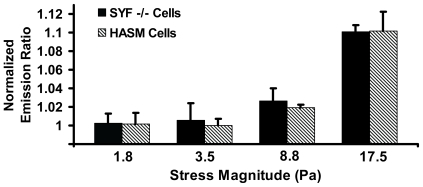
Rac activation is dependent on the stress-magnitude.Bar graphs represent the normalized emission ratios of the YPet/CFP Rac biosensor in human airway smooth muscle (HASM) cells and SYF−/− MEFs at the time point of 0.3 s upon stress application. There were no significant differences in Rac activation between 1.8 and 3.5 Pa stress, or between 3.5 and 8.8 Pa stress (p>0.05), but there were significant differences between 8.8 and 17.5 Pa stress (p<0.01), for either HASM or SYF−/− MEF cells. These data suggest that stress threshold for Rac activation is between 8.8 and 17.5 Pa. At 1.8 Pa, n = 6 or 7; at 3.5 Pa, n = 5 or 7; at 8.8 Pa, n = 5 or 8; at 17.5 Pa, n = 6; for HASM or SYF−/− MEFs, respectively. Mean +/− s.e.